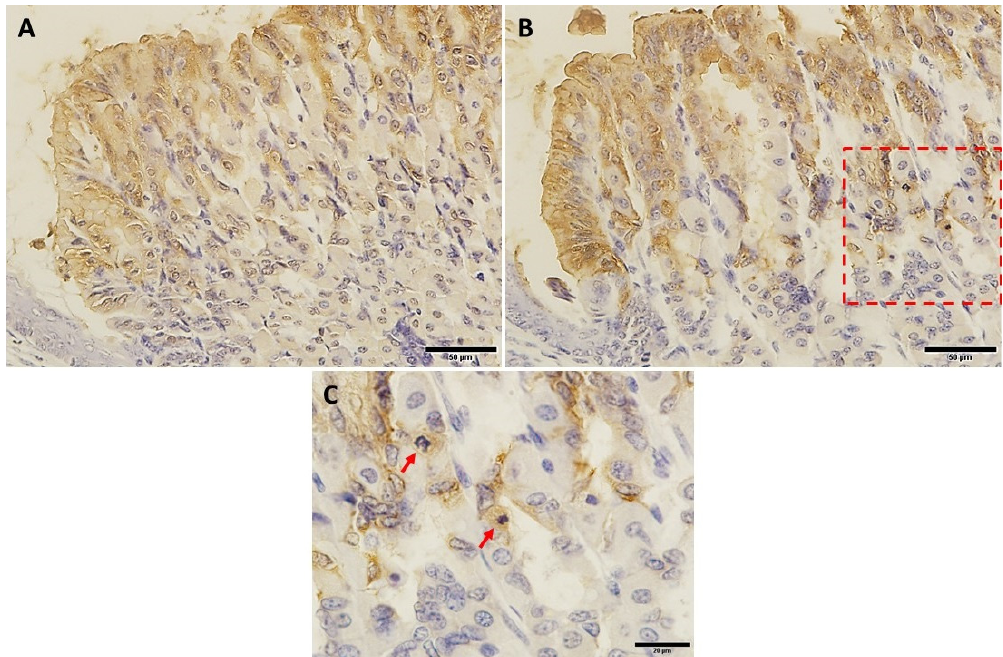
Figure 4. TFF1-labeled epithelial cells in corresponding regions of control ( A ) and VSL-treated ( B ) gastric mucosae at high magnifications. Both A and B are taken from the same region at the junction with the stratified epithelium of the fundus (lower left corner). Note the higher intensity of the brown color of TFF1-labeling in VSL-treated tissue ( B ) compared to control ( A ). Magnification bar = 50 µm. Panel C shows a high magnification of the area within the red square of the VSL-tissue. Note the TFF1-labeled mitotic progenitor cells at the arrows. Magnification bar = 20 µm.